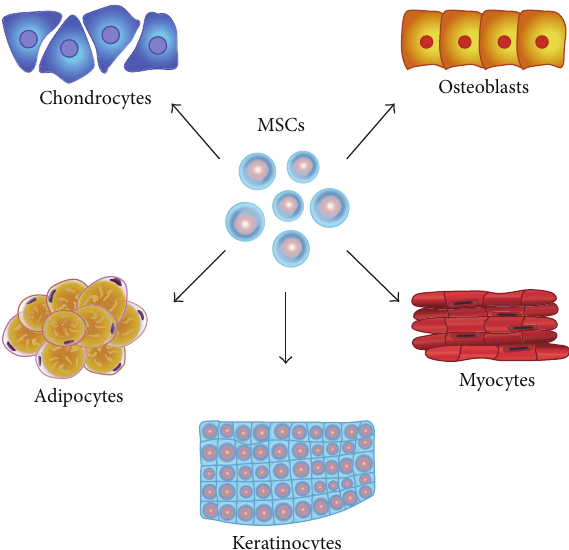
Figure 1: Multilineage potential of MSCs (mesenchymal stem cells), such as bone-marrow-derived mesenchymal stromal cells and adipose- derived stromal cells, has the potential to differentiate into various lineages, making them ideal candidates for cell-based tissue engineering strategies. It has been demonstrated that MSCs can undergo osteogenesis, chondrogenesis, adipogenesis, and myogenesis.